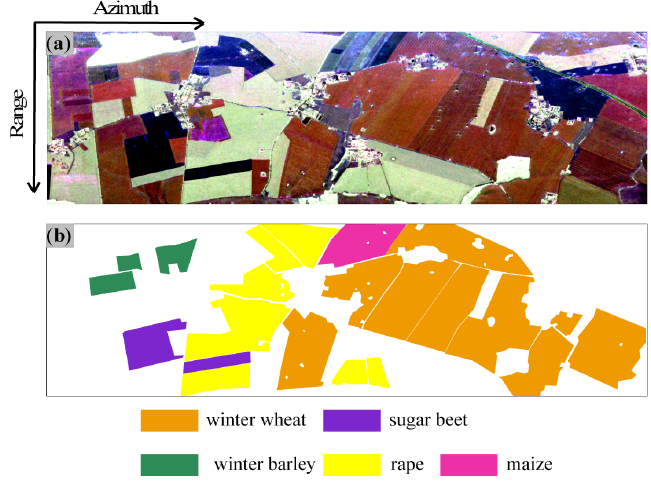
Figure 6. ( a ) The color-coded image of Pauli decomposition of the AgriSAR dataset (red: | S HH − S VV | 2 /2, green: 2 | S HV | 2 , blue: | S HH + S VV | 2 /2). ( b ) The ground truth map.